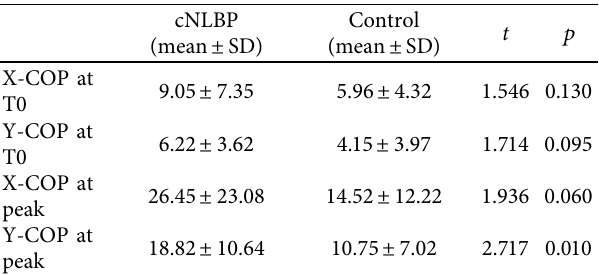
Table 5: The COP measurements of the cNLBP and control groups in the external perturbation